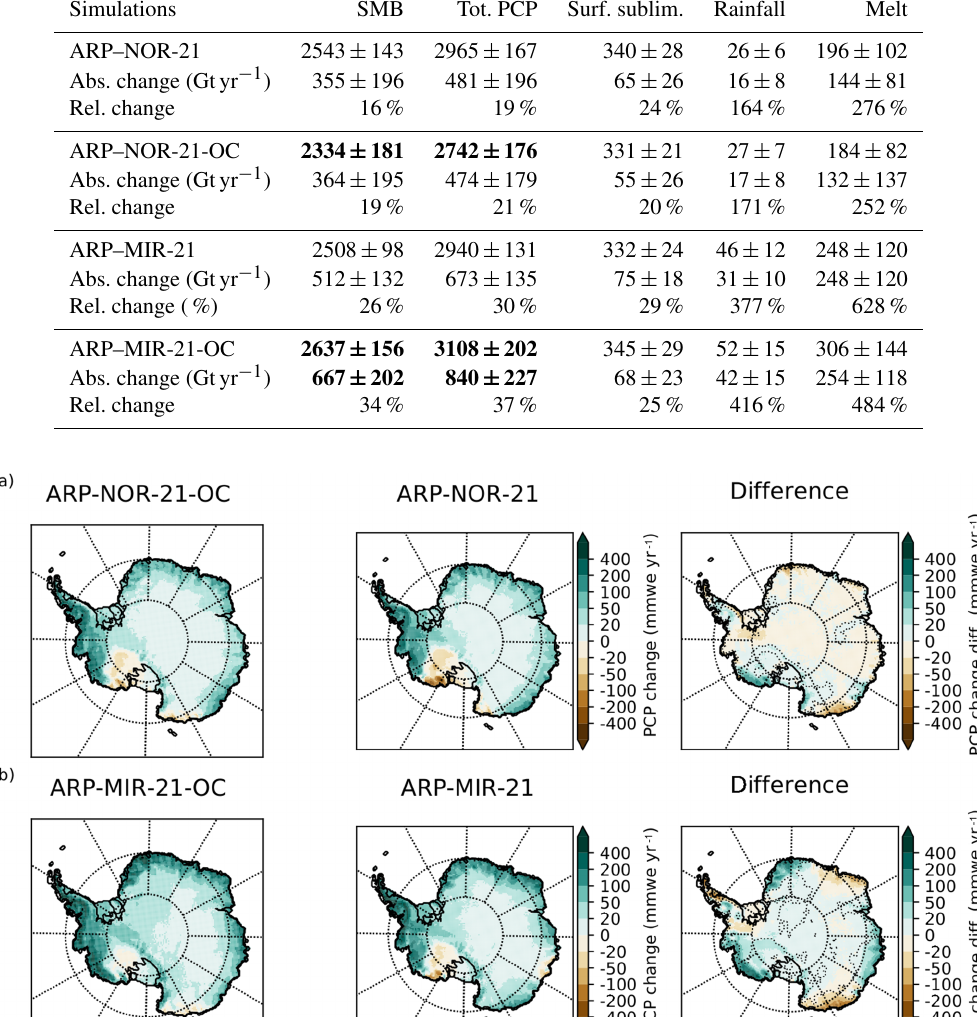
Table 7. Absolute values, absolute change (Abs. change, Gtyr − 1 ) and relative change (Rel. change, %) for mean SMB, precipitation, surface sublimation, rainfall and melt for the grounded AIS for the different ARPEGE RCP8.5 projections (2071–2100). Climate change signals and absolute values significantly different at the p = 0 . 05 level in projections with bias-corrected SSCs are displayed in bold.